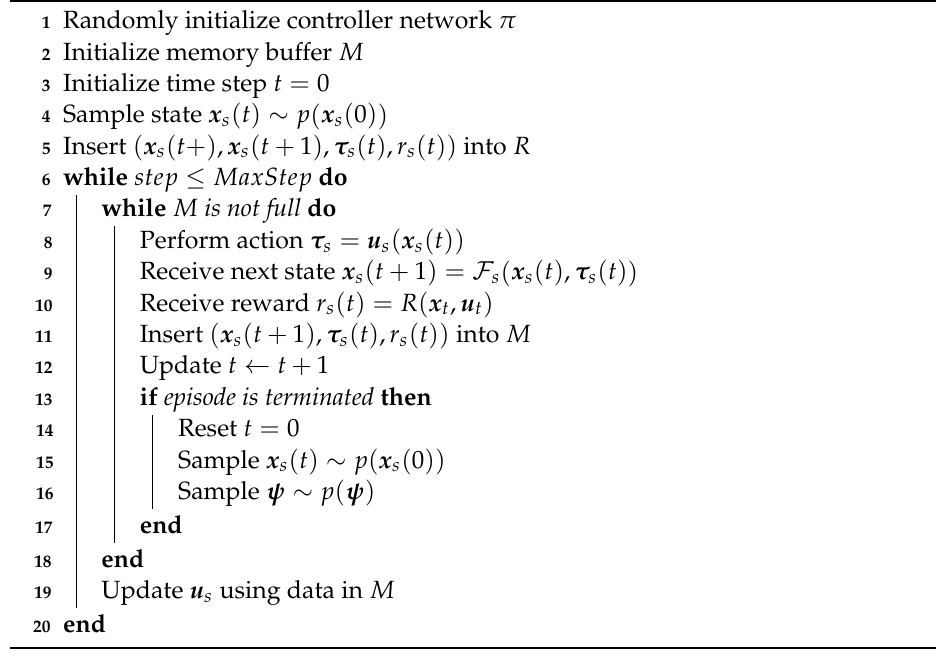
Algorithm 1: Learning Source Controller